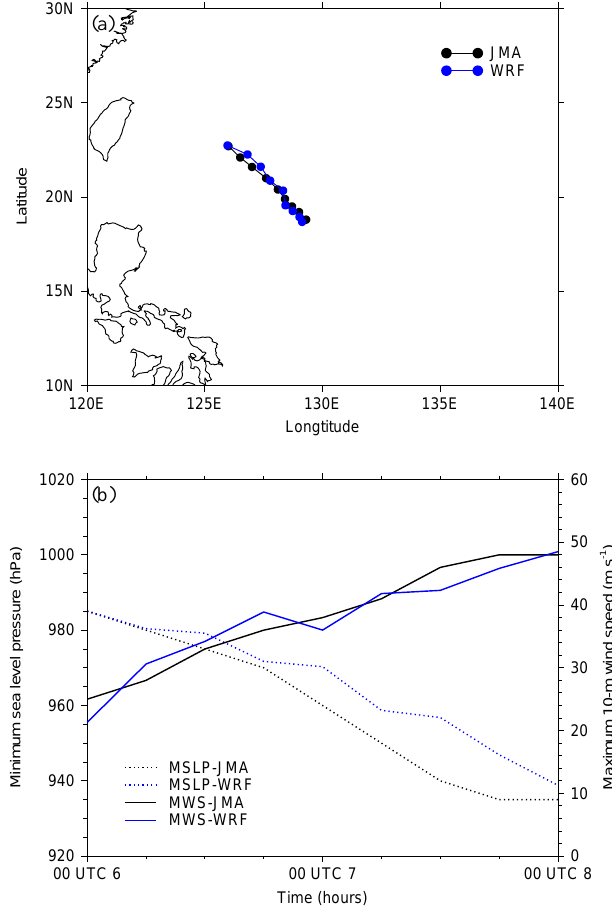
Figure 1. ( a ) Typhoon track and ( b ) minimum sea level pressure (MSLP; dotted line) and maximum 10-m wind speed (MWS; solid line) in the JMA observation (black) and simulation (blue).